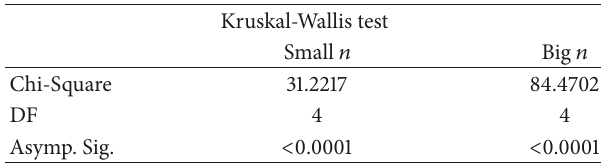
Table 4: Kruskal–Wallis test statistics for both small and large number of jobs.